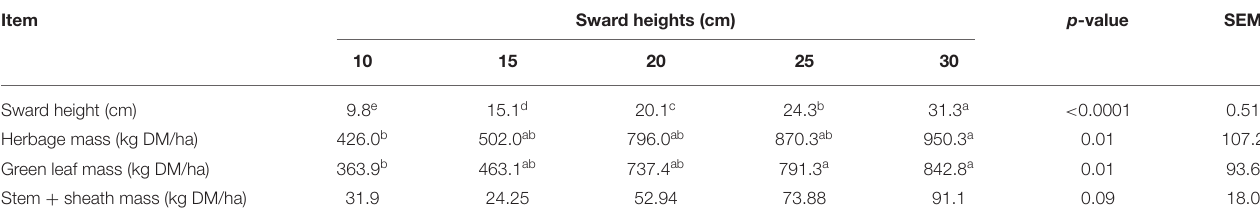
TABLE 1 | Sward characteristics of herbage samples from the top stratum of five Kikuyu sward height. Item